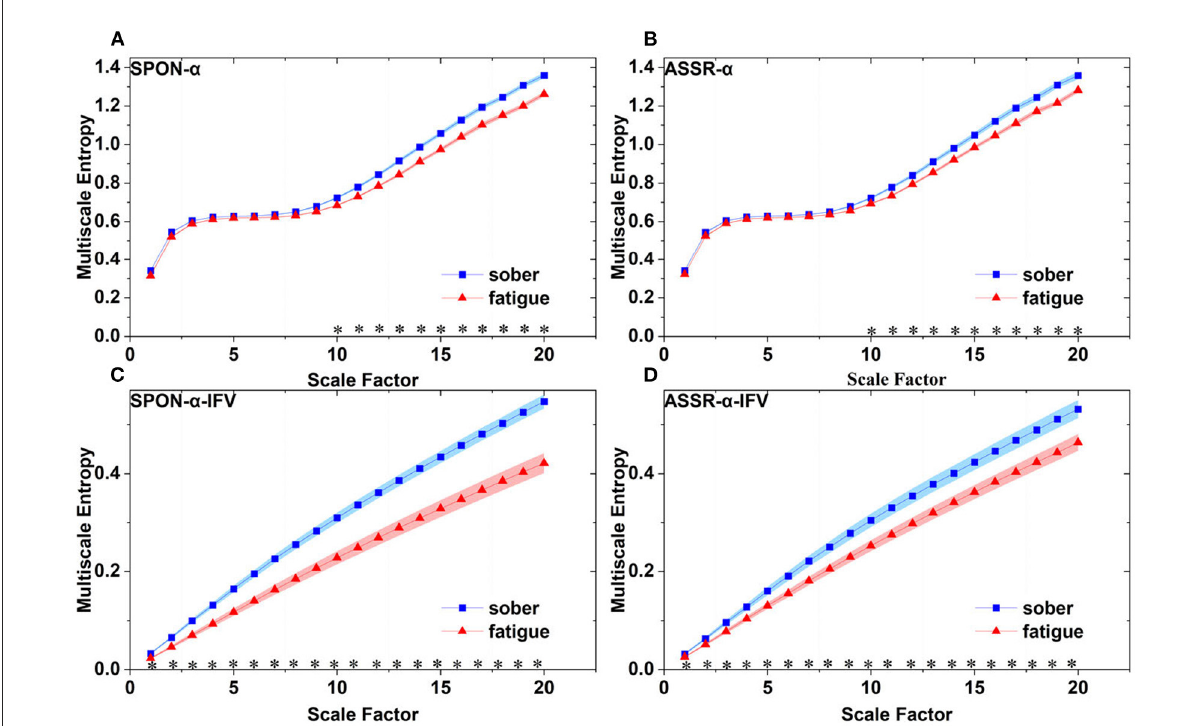
FIGURE7 Comparison of MSE from parietal lobe (channel P4) on: (A) alpha rhythm from spontaneous EEG (SPON- α ), (B) alpha rhythm from ASSR (ASSR- α ), (C) IFV in alpha rhythm from spontaneous EEG (SPON- α -IFV), and (D) IFV in alpha rhythm from ASSR (ASSR- α -IFV). The sign * indicates significance at p < 0.05. Shades indicate the standard